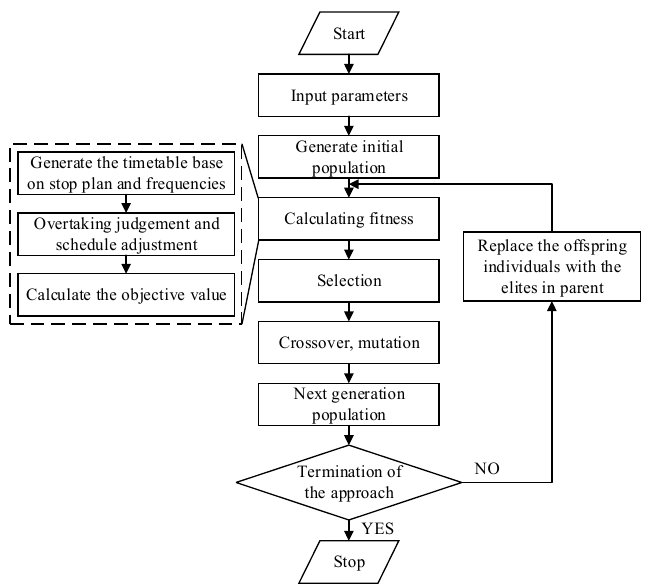
Figure 4. Flowchart of the algorithm designed to solve the optimization model.